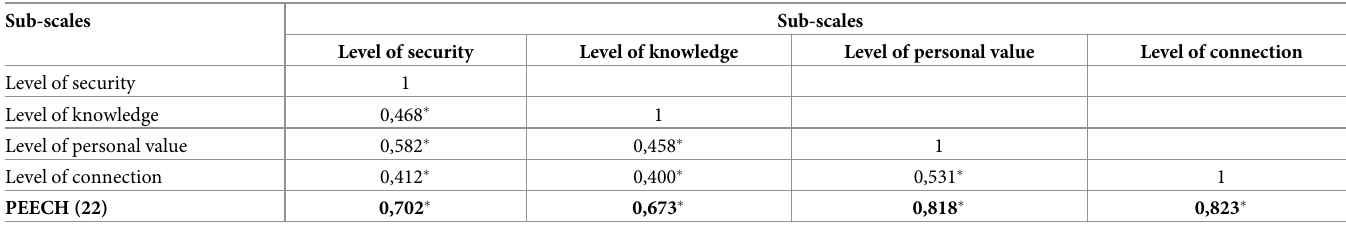
Table 7. Correlations between sub-scales (n =